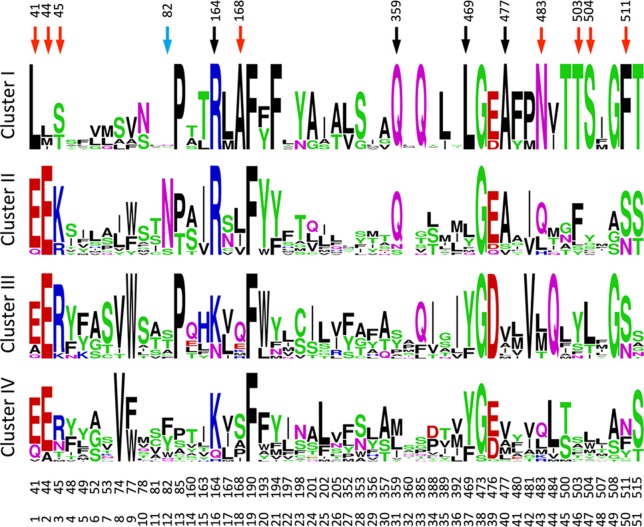
Sequence logos for the transporters in the four clusters. The figure was made in the WebLogo program (Crooks et al., 2004). Red, blue, and black arrows mark positions unique for cluster I, cluster II, and for clusters I and II, respectively.